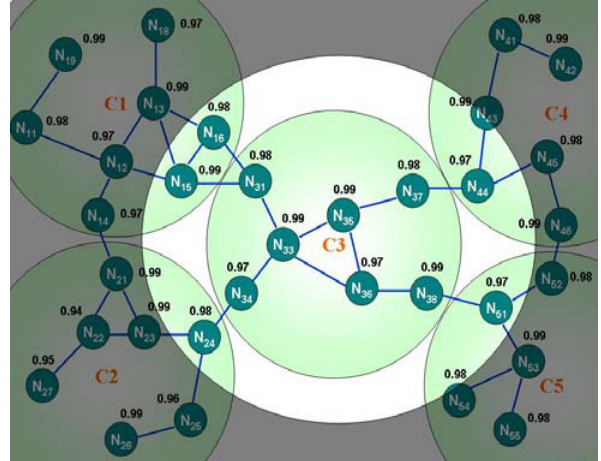
Figure 8. Intra-cluster routing.